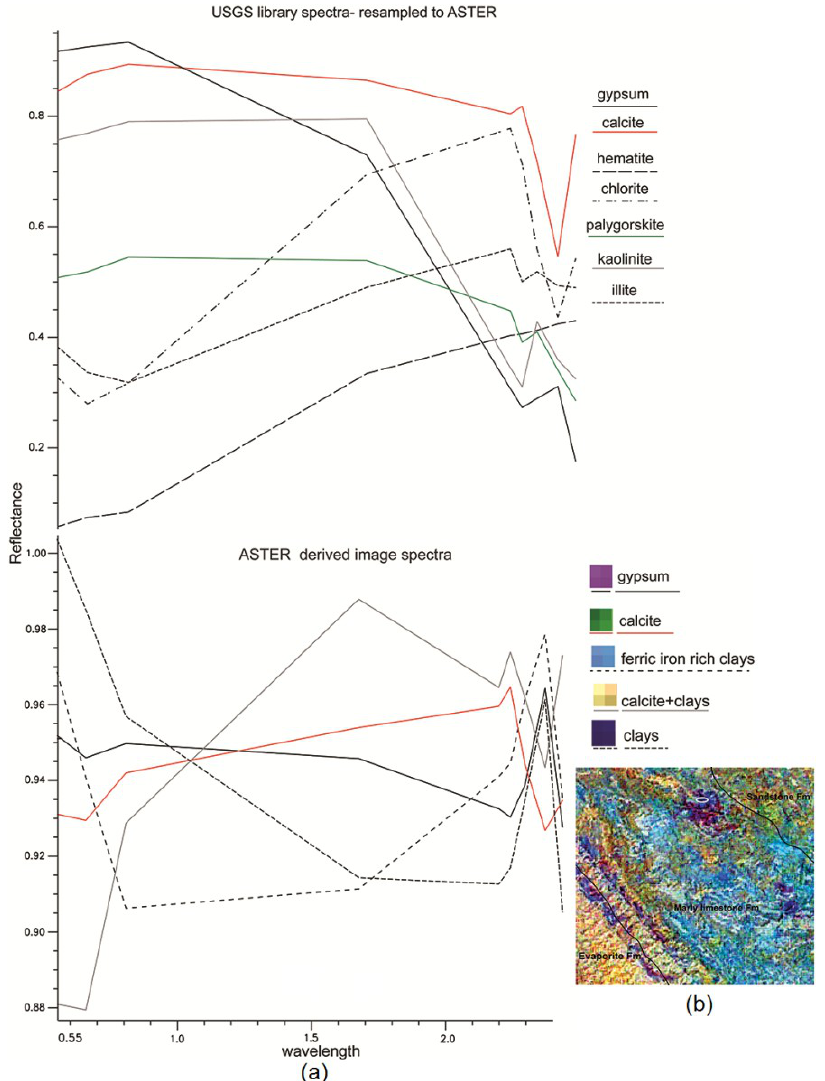
Figure 4. ( a ) Mean spectra derived from ASTER imagery compared to the USGS (US Geological Survey) spectral library re-sampled to the ASTER; ( b ) FCC image created from ASTER bands. The band combination used is (RGB)